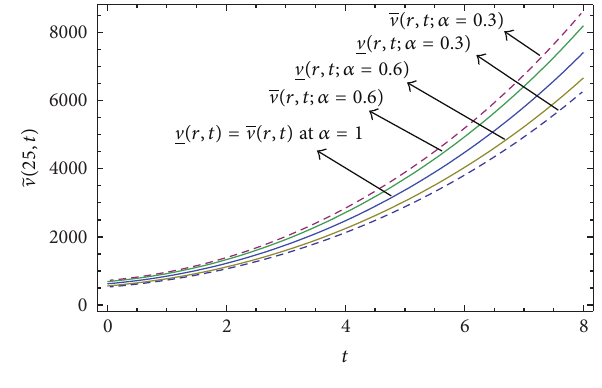
Figure 6: Interval solution of Case 1.